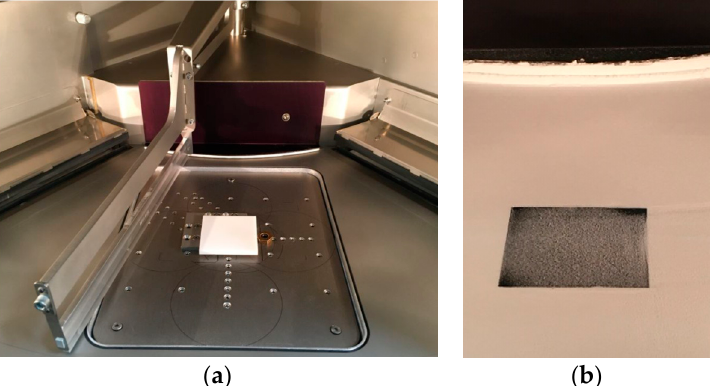
Figure 1. ( a ): Polyamide 12 (PA12) substrate fixed onto the custom-built ground plate. ( b ): PA6 substrate embedded in PA12.